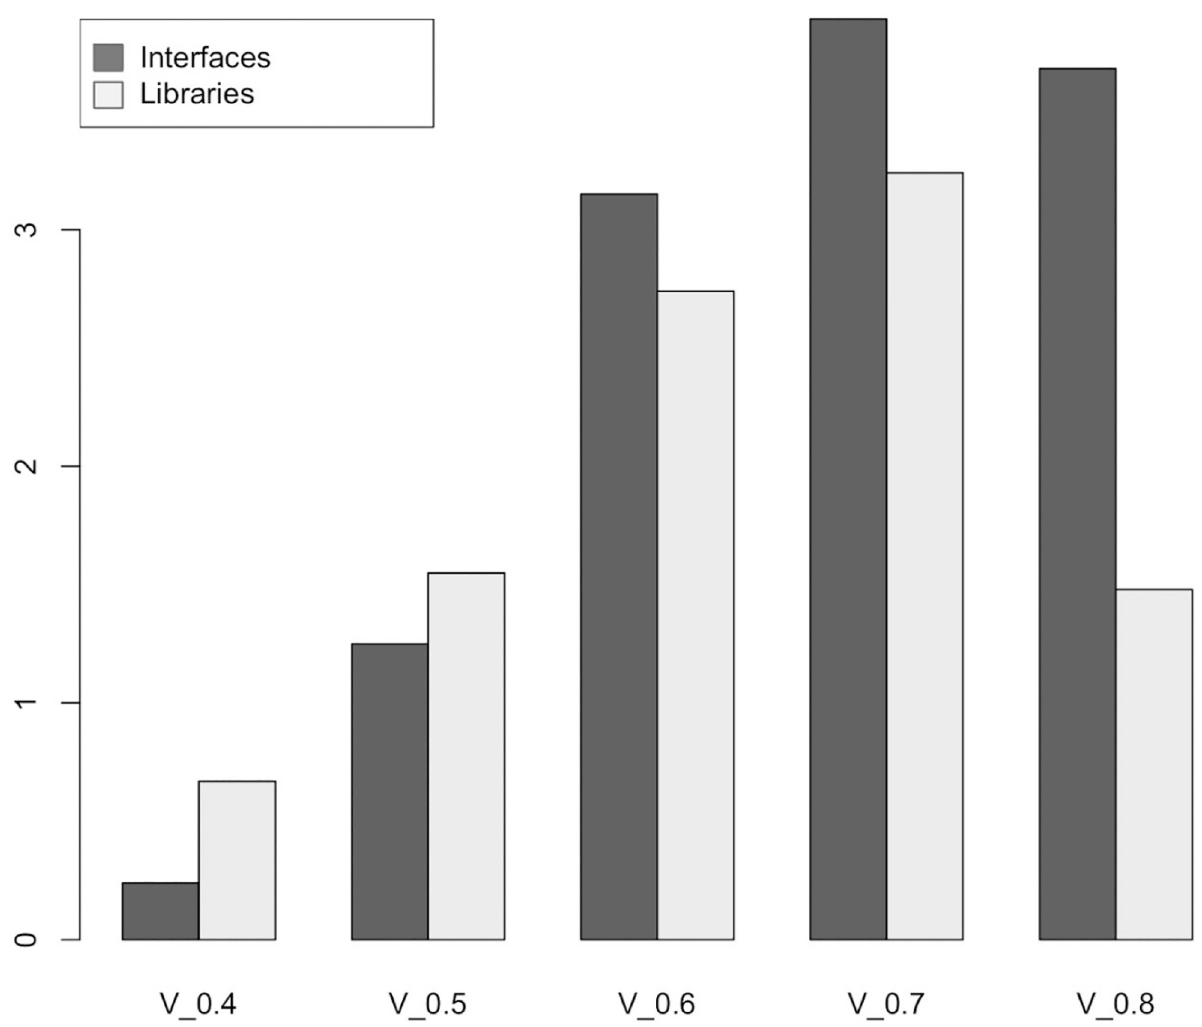
Fig 6. The average number of interfaces and libraries in Smart